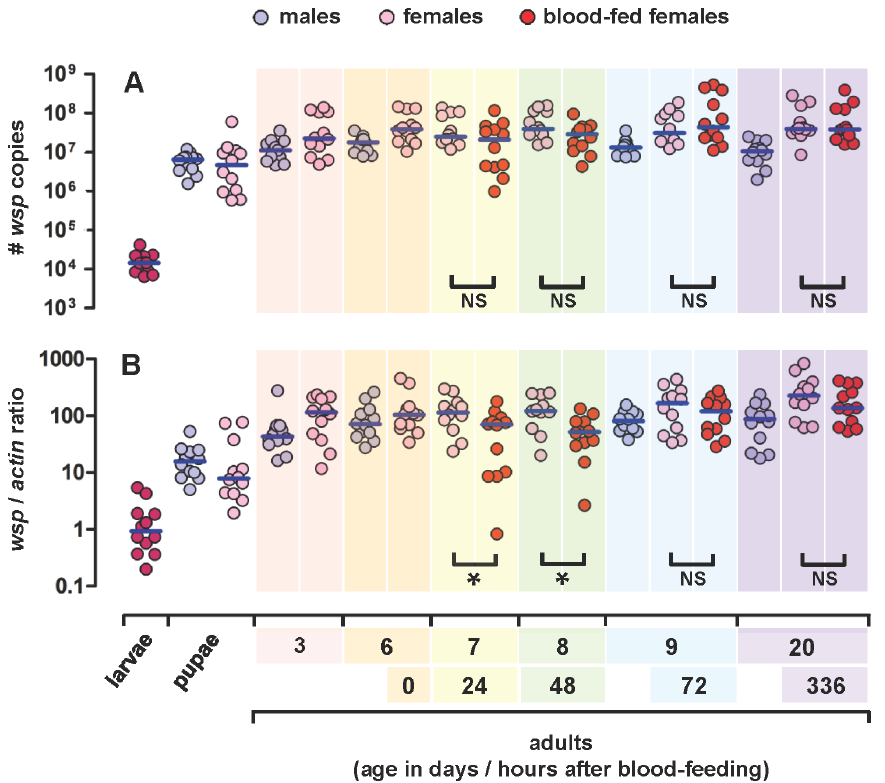
Figure 7. Stage-, sex-and diet-specific density of w Flu in Ae.fluviatilis . Graphs showing the absolute (A) and relative (B) densities of w Flu throughout the life cycle of the wildtype strain ( wolb + ) of the mosquito Ae. fluviatilis . The density of w Flu was estimated using real-time quantitative PCR of the Wolbachia -specific wsp gene and the mosquito-specific actin gene (see Materials and Methods for details). Each circle represents a single, whole individual, while the blue horizontal bars indicate either the median number of wsp copies (Graph A) or the median wsp / actin ratio (Graph B) per individual. The data shown are from three independent biological replicates (i.e., three different cohorts – generations – of the laboratory colony of Ae. fluviatilis ). For each life cycle stage/sex/diet type, 4 individuals were assayed from each of the three cohorts, so that in total 12 individuals were used. For each cohort, adult females were separated into two groups 6 days after eclosion from pupae, and one group was blood-fed on the same day, such that 7, 8, 9 and 20 day-old adults are, respectively, 24, 48, 72 and 336 hours after blood-feeding, while the other group of age-matched adult females was maintained on sugar only. After day 9, blood-fed females were allowed to oviposit, so that fully-developed eggs would not be retained. As the sex of larvae cannot currently be unambiguously determined for aedine mosquitoes, only a single group representing an unknown mix of randomly selected male and female 4 th instar individuals was assayed. Comparisons marked with an asterisk (*) were significantly different between sugar- and blood-fed females using a Mann-Whitney U test, while comparisons marked with ‘‘NS’’ were not significantly different between sugar- and blood-fed females. Statistically significant differences were also observed between different life cycle stages and sexes as described in the main text. mosquito actin-1 gene: forward: 5 9 - ACC GAG CGT GGC TAC